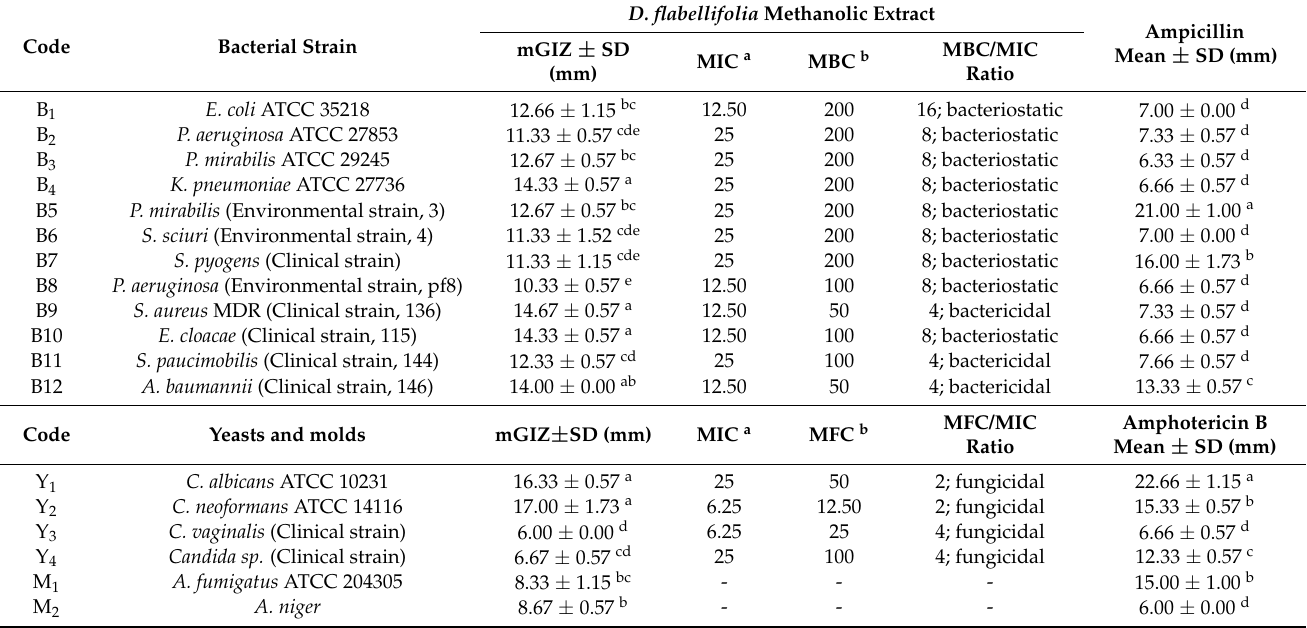
Table 3. Growth inhibition zone, MICs, MBCs, and MFCs values obtained using disc diffusion and microdilution assays.